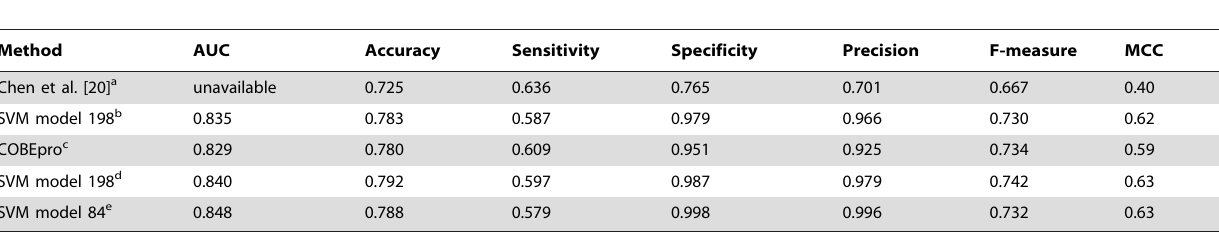
Table 3. Comparison of predictive quality on the ChenFrag dataset calculated using either 10-fold cross validation or 5-fold cross validation to match the test type from the corresponding manuscripts. The methods are sorted by their AUC values in the ascending order.